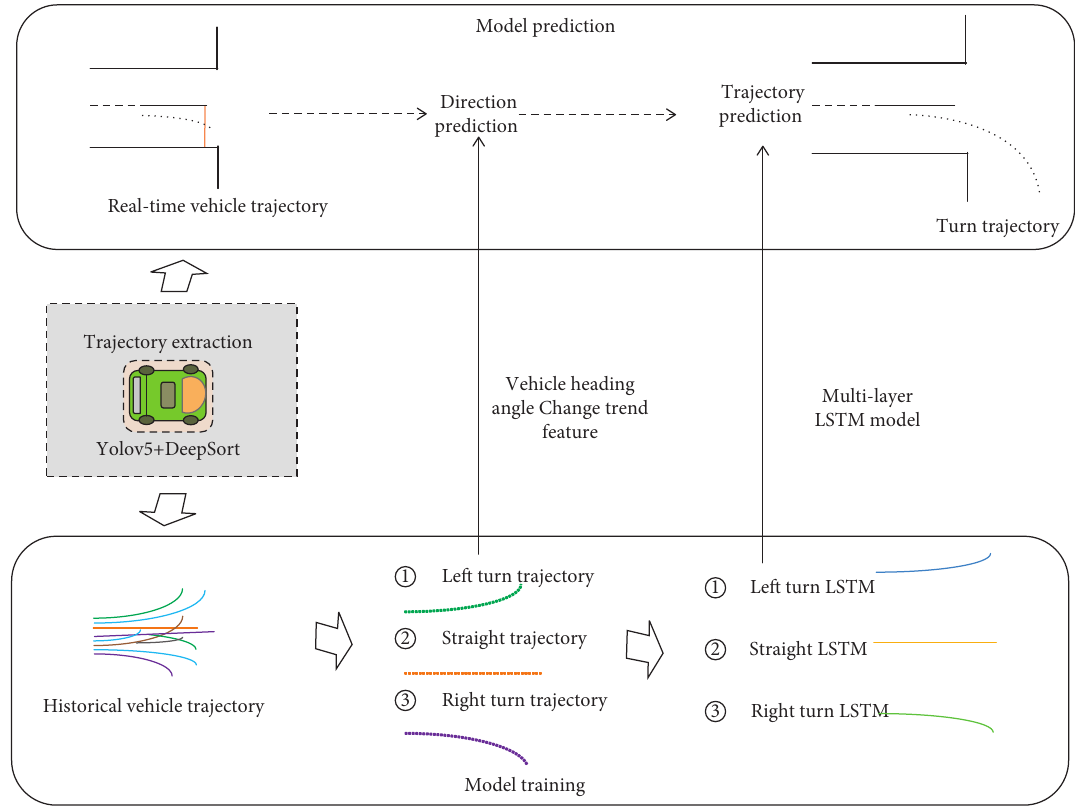
Figure 3: Schematic diagram of the forecasting method.